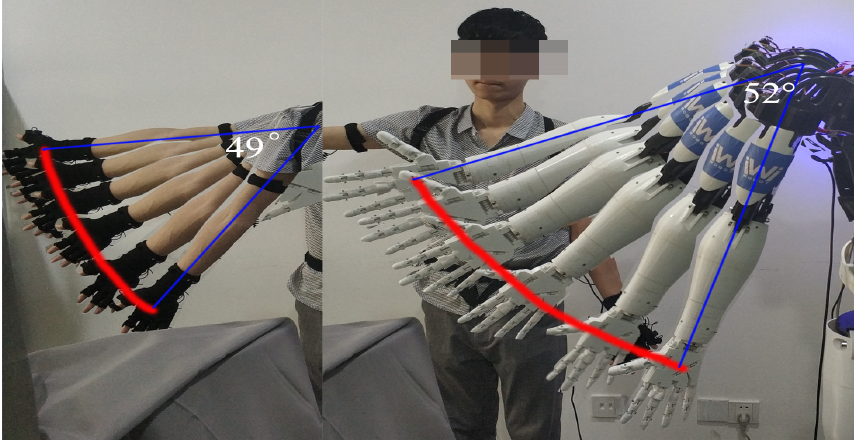
Figure 14. Snapshots for motion